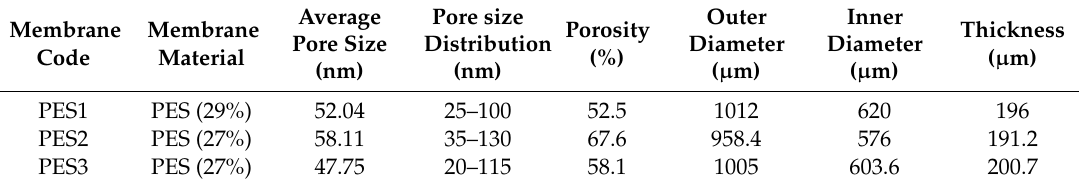
Table 1. Characteristics of the polyethersulfone (PES)